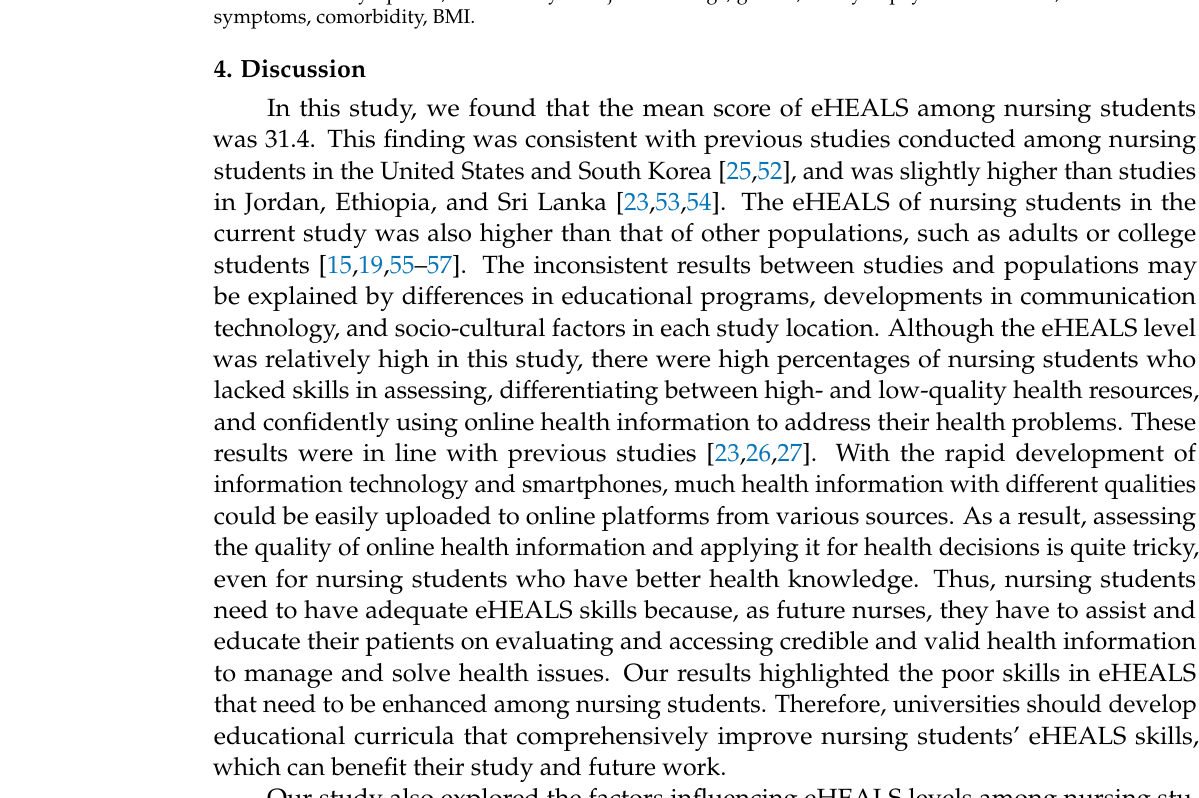
Table 5. Associations of eHealth literacy with fear of COVID-19, anxiety, and depression (n = 1851). Fear of COVID-19 a Anxiety b Depression c Variable B (95% CI) p OR (95% CI) p OR (95% CI) p eHealth literacy 1-score increment Unadjusted Model 0.01 ( − 0.05, 0.05) 0.941 0.95 (0.92, 0.98) Adjusted Model 0.01 ( − 0.04,